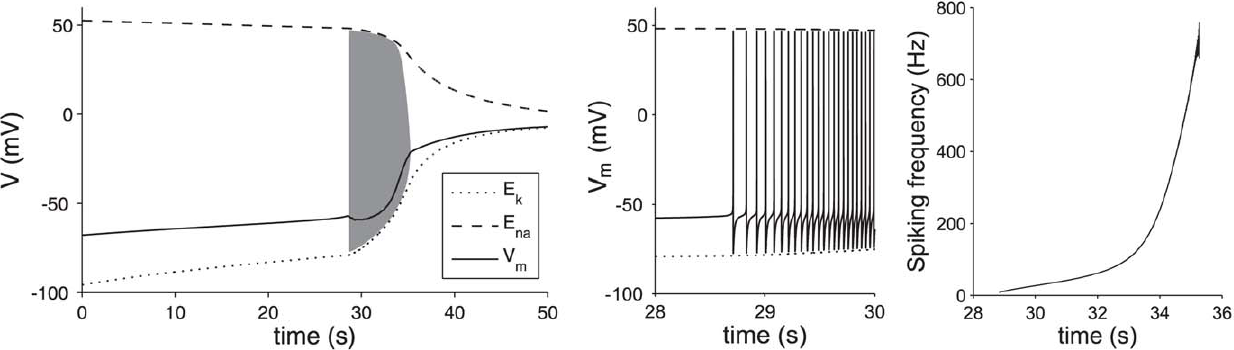
Figure 2. Membrane dynamics during oxygen-glucose deprivation. In the left panel the membrane dynamics are shown that occur after the onset of OGD (solid line). The dashed and dotted lines show the progressive loss of ion gradients. When after a gradual rise the membrane potential reaches the excitation threshold, this subsequently results in spiking of the membrane voltage according to Eqns 1 and 2 (gray region, not resolved). The black line shows the average membrane potential during the spiking (averaged over 300 ms). After approximately 7 seconds of oscillations, the cell comes to rest again, with a resulting V m & { 20mV . The middle panel shows a close up of the start of spiking activity, the right panel shows the instantaneous firing